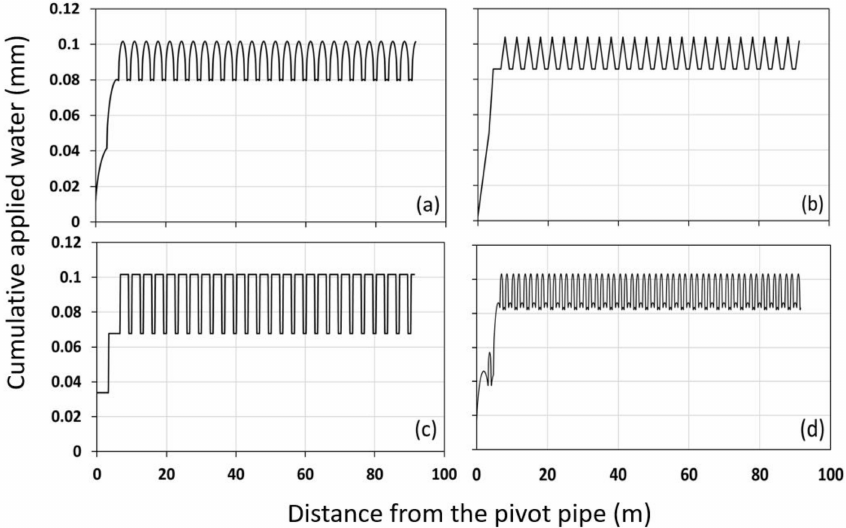
Figure 3. Different application patterns of sprinklers along the pivot lateral for an elliptical ( a ), triangular ( b ), rectangular ( c ), and donut ( d